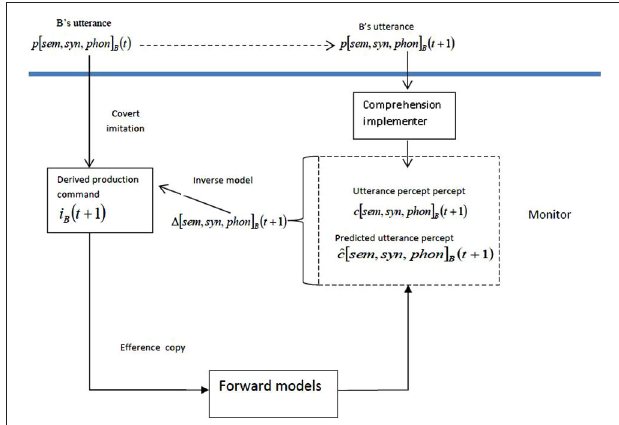
FIGURE 2 | Other-monitoring using forward models. Information above the line (and underlined) refers to B , and indicates the representations underlying the utterance at time t and the upcoming utterance. The arrow is dotted because the relationship between the two representations is not causal for A . A uses covert imitation, including access to the inverse model and context (i.e., differences between A and B ) to derive B’ s production command, and then uses forward models to derive the predicted utterance percept. A then comprehends B’ s utterance and compares the utterance percept and the predicted utterance percept. The output of the comparison is the discrepancy between the predicted and actual percepts, and it provides the input to the inverse model that can be subsequently used to modify the derived production